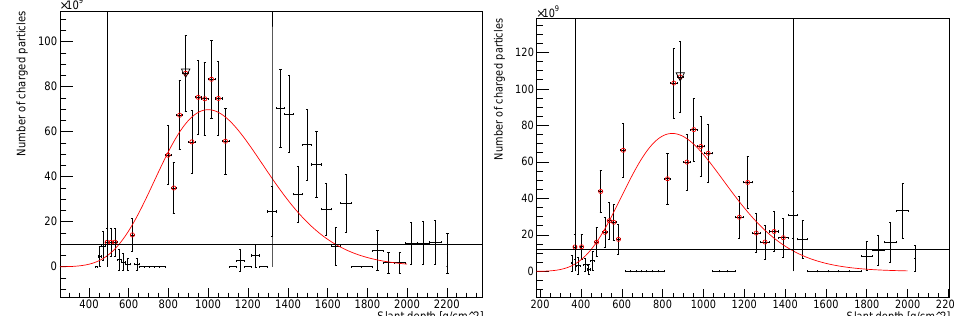
Figure 15. Examples of reconstructed shower profiles as a function of slant depth. Both showers were generated by simulated 100 EeV UHECRs arriving at 60 ◦ zenith angle. The red curves indicate shower profile fits. Red circles mark data points used for the reconstruction. Vertical black lines show boundaries of the interval selected for the reconstruction by the algorithm. Horizontal black segments correspond to gaps between PDMs and/or PMTs.